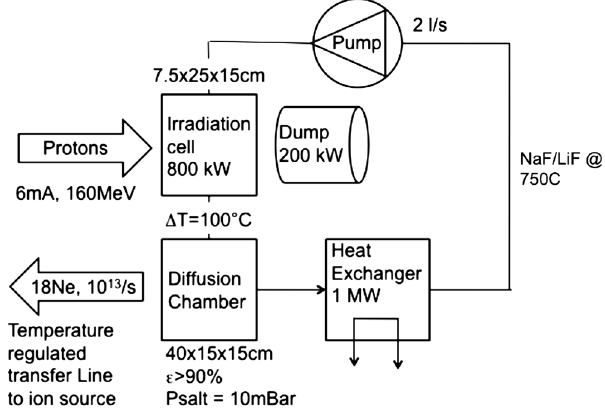
FIG. 17. A NaF molten salt loop for the production of 18 Ne ions.